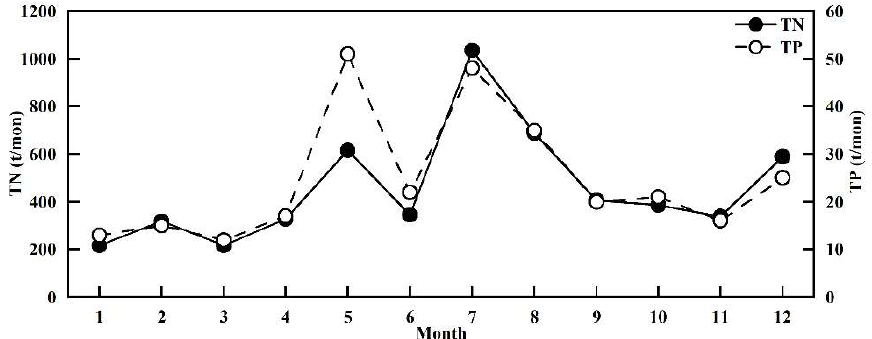
Figure 7. Intra-annual variation of TN and TP loadings for inflow rivers.